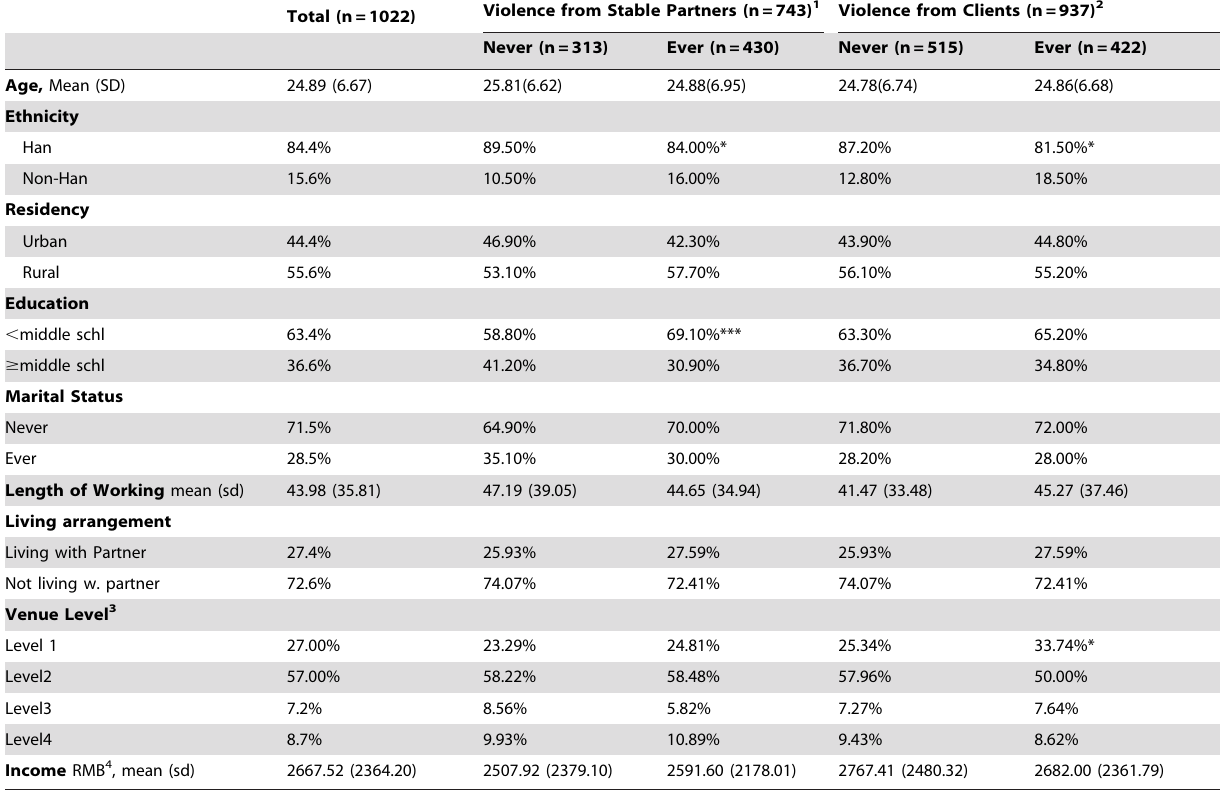
Table 1. Demographic characteristics of FSWs and relationship with Partner